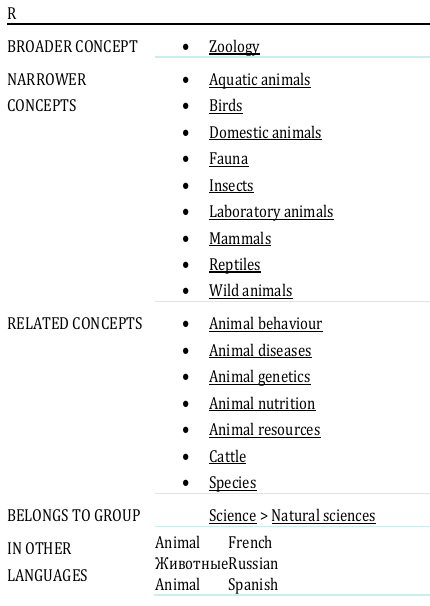
Figure 3. An example from UNESO Thesaurus [47].